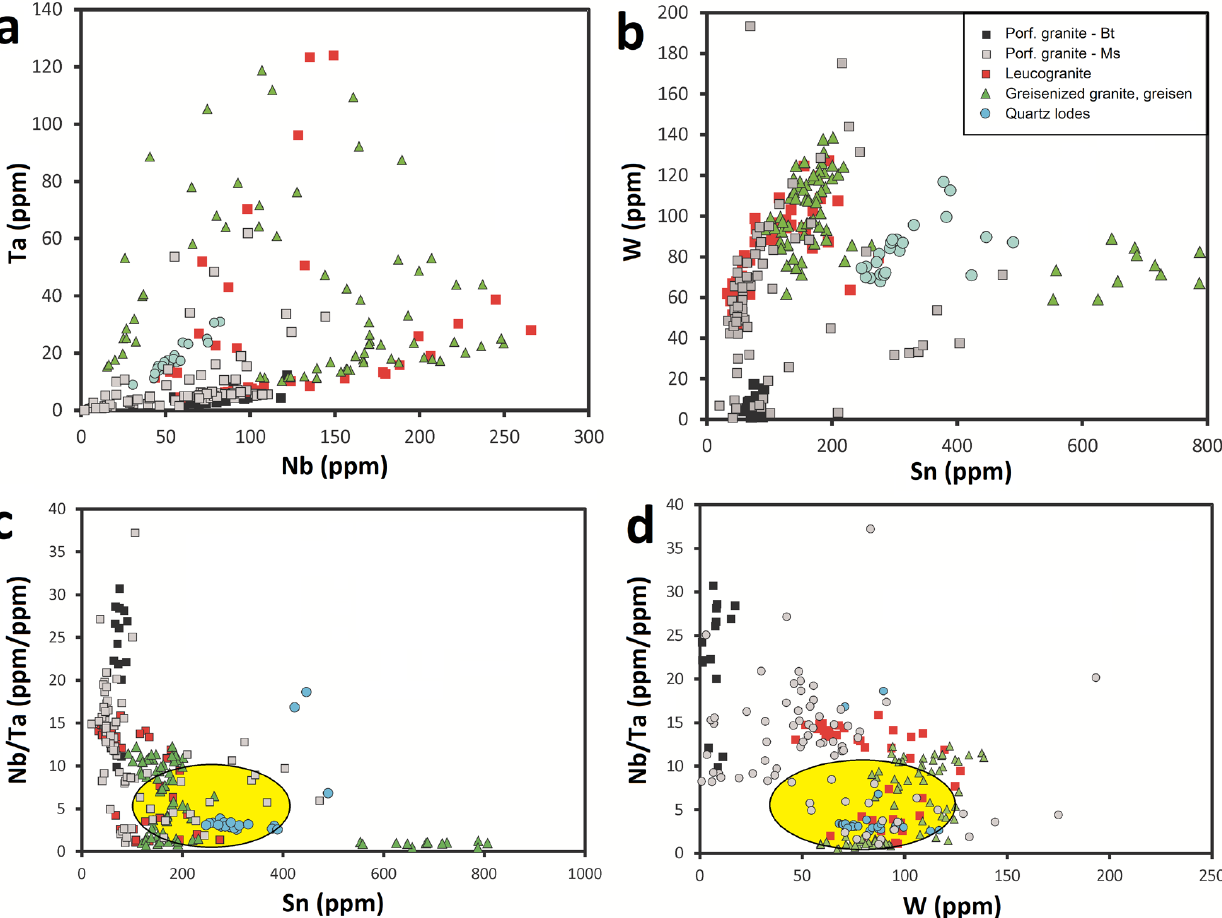
Figure 16. Relations among HFSE metals in mica: ( a ) Nb vs. Ta; ( b ) Sn vs. W; ( c ) Nb/Ta vs. Sn; ( d ) Nb/Ta vs. W. Yellow fields indicate locations of the majority of greisen and vein micas analyzed by [14].